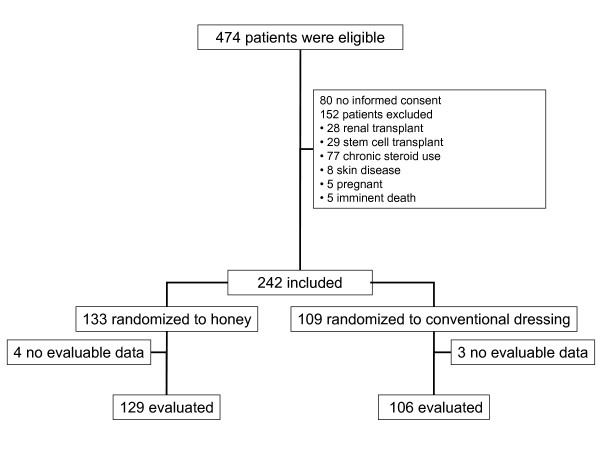
CONSORT flow diagram.